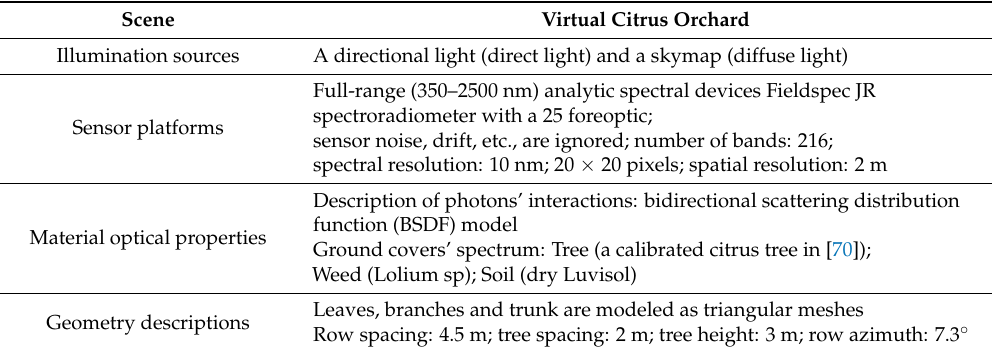
Table 12. Comparison of the algorithms for the virtual orchard and real hyperspectral datasets.